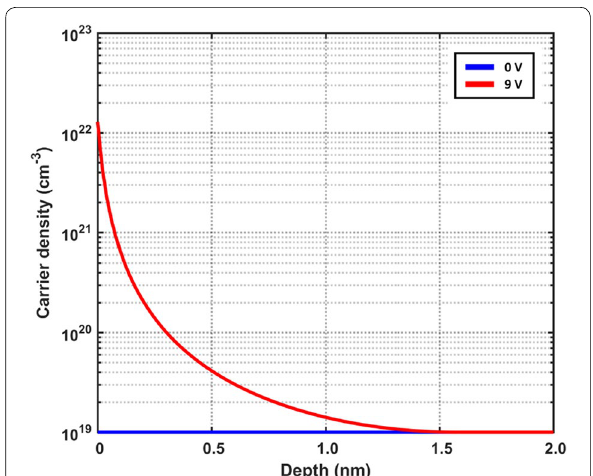
Fig. 3 Carrier density distribution inside the ITO layer based on the MOS model. In calculation, the intrinsic carrier concentration of ITO is assumed 10 19 cm − 3 (blue line) while 9 V of voltage bias causes the concentration to increase to 1.2 10 22 cm − 3 near the interface (red ×